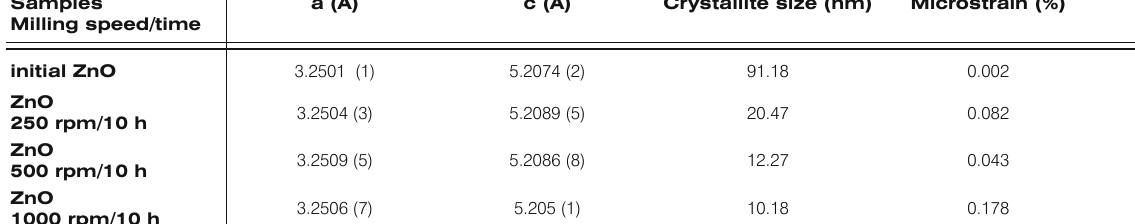
Table 1. Lattice parameter, crystallite size and mcirostain of ZnO powders mechanically activated at 250, 500 and 1000 rpm. Samples Milling speed/time